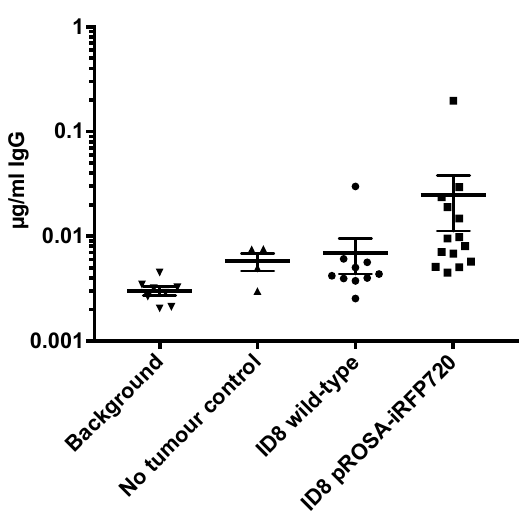
Figure 5. Circulating endogenous iRFP720-specific IgG antibodies in mice bearing pROSA-iRFP720 ID8 tumours. Serum iRFP720-specific IgG antibodies ( µ g/mL) in the sera of pROSA-iRFP720 ID8 and wild-type ID8 tumour-bearing mice at the endpoint ( n = 4–14). Bars represent ± SD.